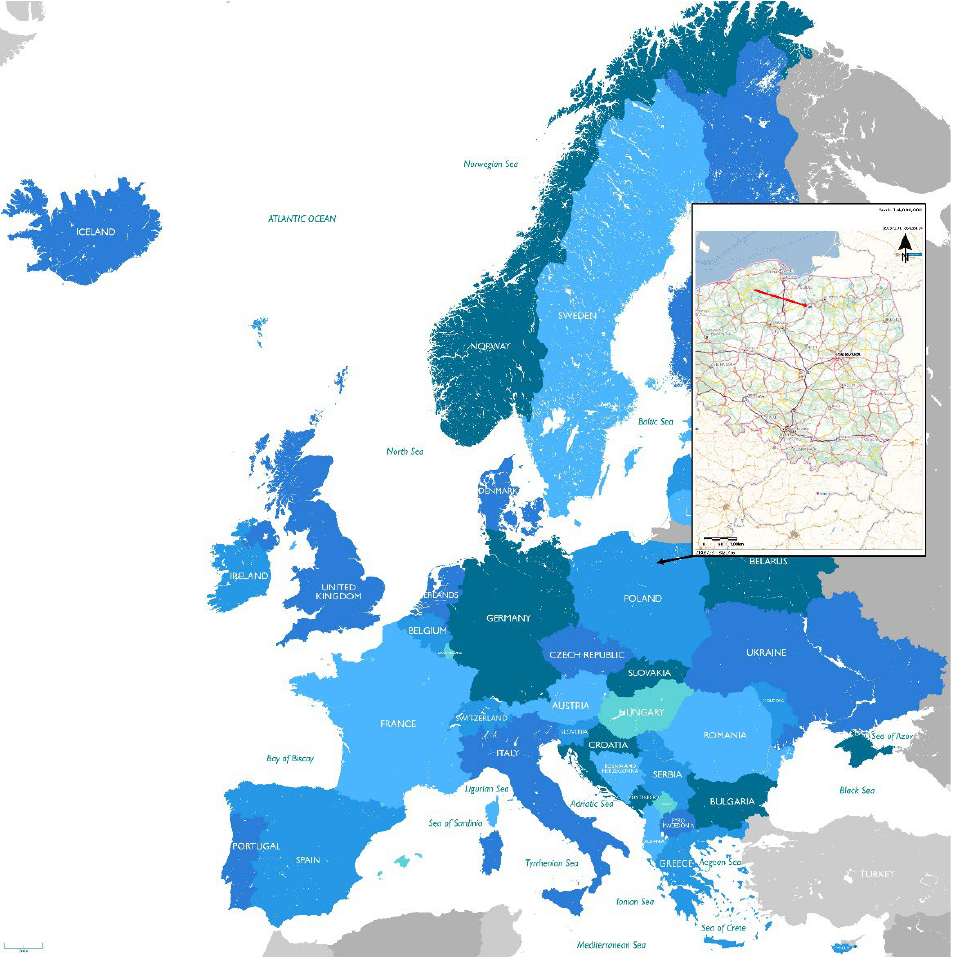
Figure 1. The localization of the experiment.